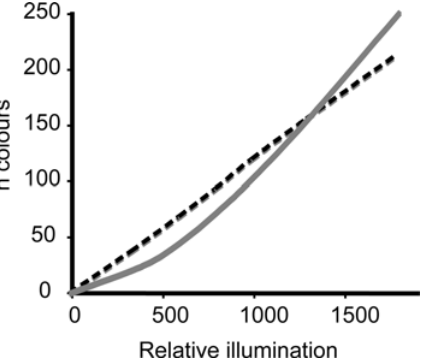
Figure 1. The relative number of colours (n colours) that a dichromat (dashed black line) and a trichromat (grey solid line) can discriminate in dim light. Due to the high noise levels in dim light intensities a dichromat should theoretically discriminate more colours than a trichromat. Adapted from [6].